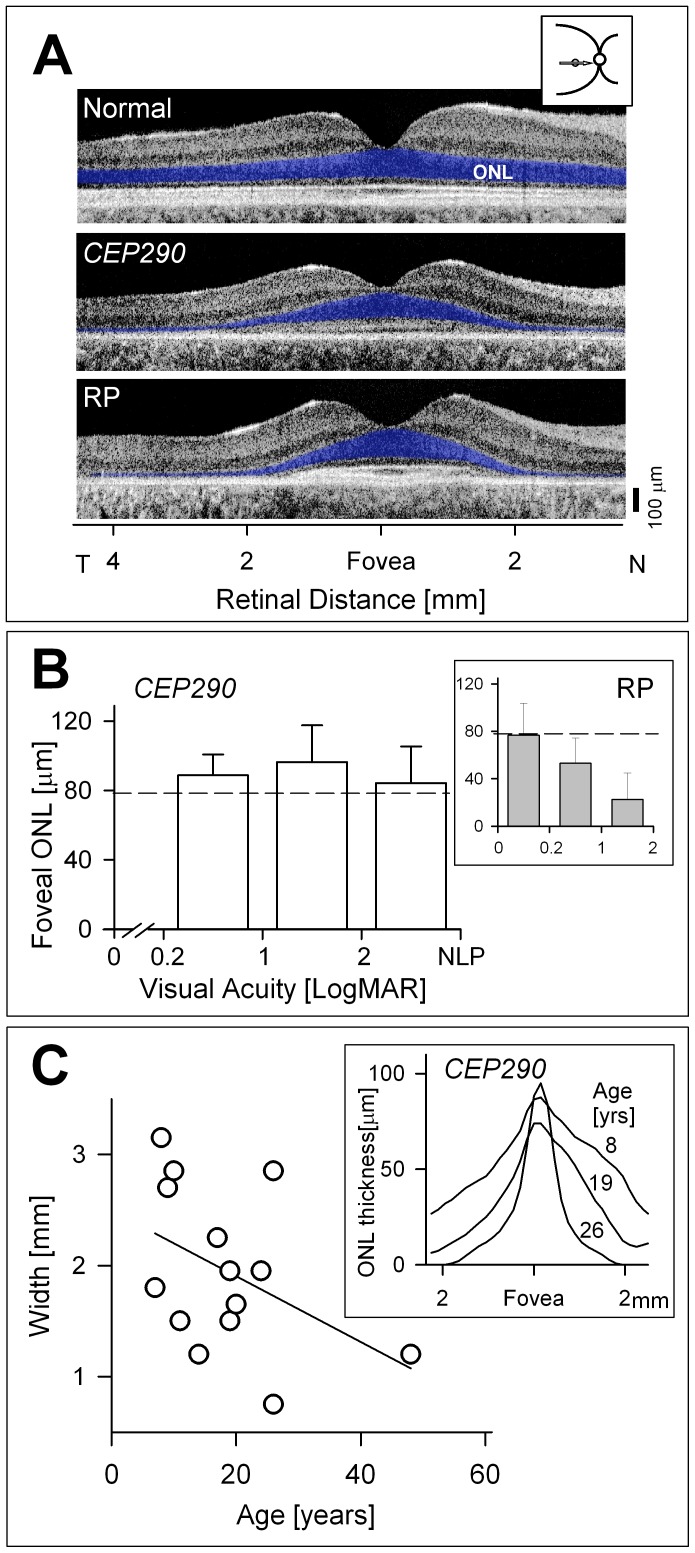
Structure and function in the central retina of CEP290-LCA patients.(A) Cross-sectional OCT scans along the horizontal meridian through the fovea in a normal subject, a CEP290-LCA patient, and an RP patient. ONL is highlighted in blue. Inset shows location of scan. (B) Relationship of foveal ONL thickness and visual acuity in CEP290-LCA patients. Bar graph represents the average ±1SD foveal ONL thickness of eyes in the different visual acuity ranges (n = 3, for 0.1–1 LogMAR; n = 5, for 1–2 LogMAR; and n = 11, for 2–NLP). Dashed line is lower limit of normal and emphasizes that despite low acuities, foveal ONL is within normal limits. Inset, data from a series of RP patients plotted similarly to show the more expected relationship between structure and visual acuity in retinal degenerations (n = 3, for 0–0.2 LogMAR; n = 20, for 0.2–1 LogMAR; and n = 3 for 1–2 LogMAR). Dashed line is also lower limit of normal. (C) Relationship in CEP290-LCA patients of width of the ONL in the central retina and patient age at time of examination. ONL width was unable to be defined in a 32-year-old CEP290-LCA patient with maculopathy. Solid line is linear regression. Inset, traced central ONL peaks in representative patients of different ages.